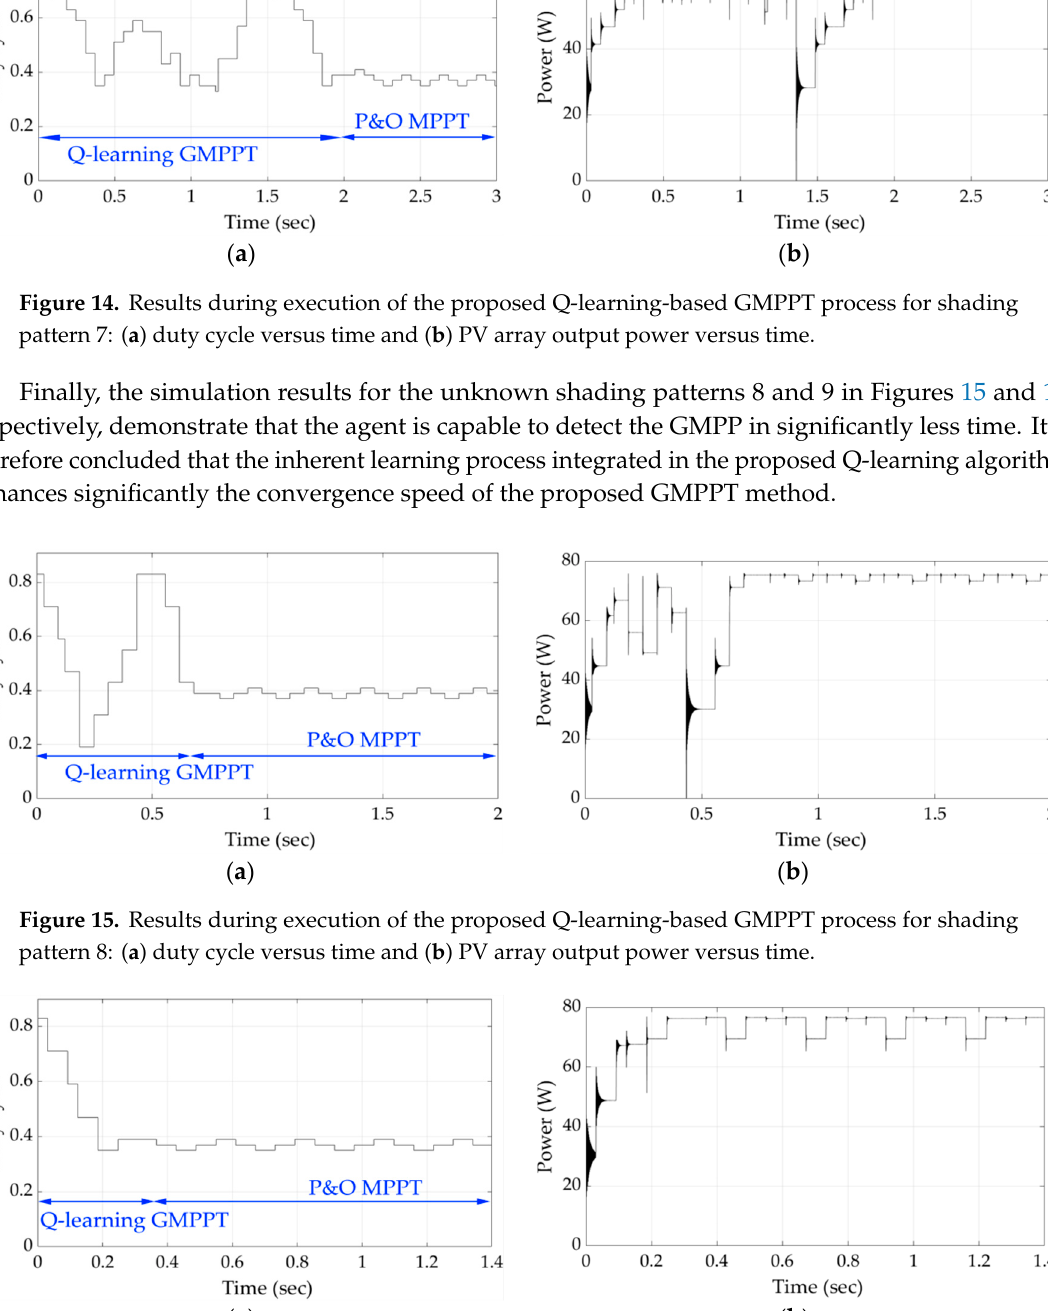
Figure 16. Results during execution of the proposed Q-learning-based GMPPT process for shading pattern 9: ( a ) duty cycle versus time and ( b ) PV array output power versus time.